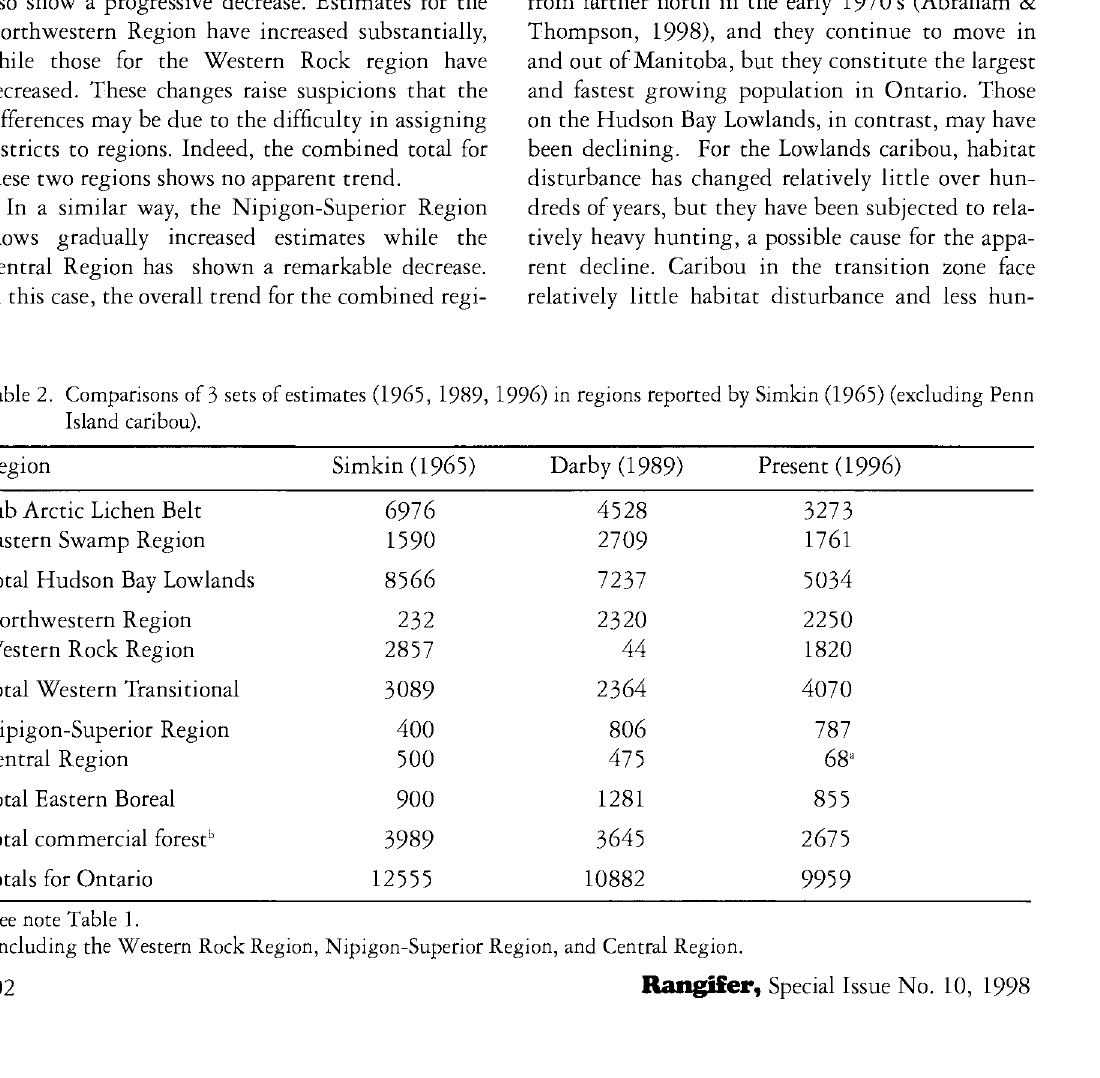
Table 2. Comparisons of 3 sets of estimates (1965, 1989, 1996) in regions reported by Simkin (1965) (excluding Penn Island